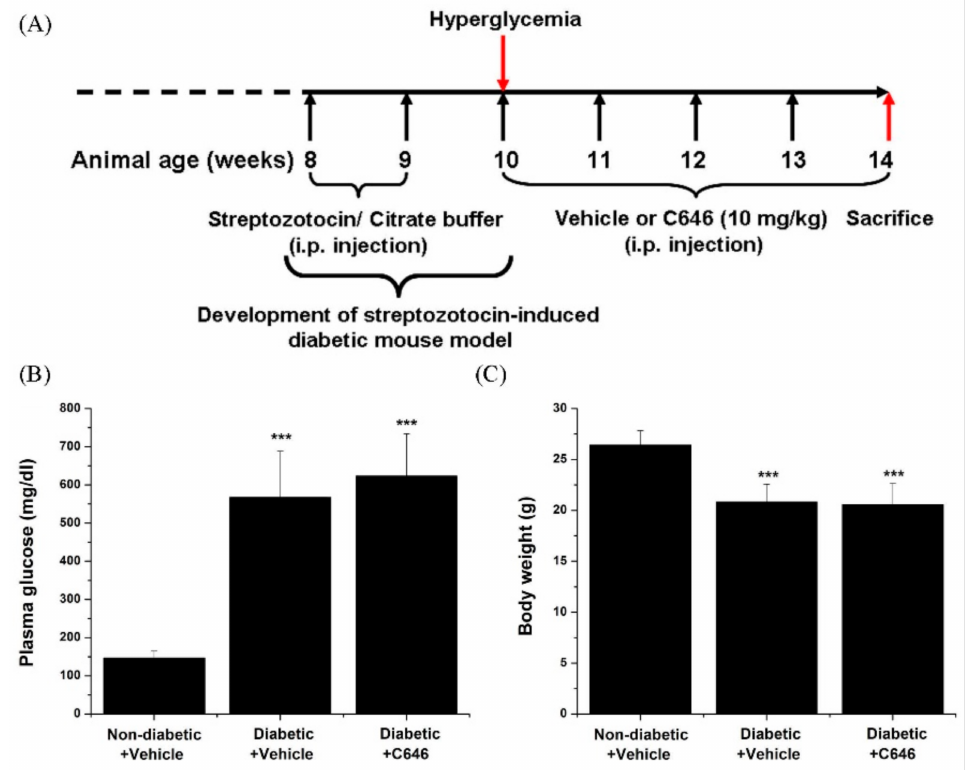
Figure 1. ( A ) Schematic depiction of the experimental set-up to induce diabetes in C57BL/6J mice and the duration of C646/vehicle administration to mice. ( B , C ) Plasma glucose levels and body weights were assessed for each animal group at the end of the treatment procedure. n = 5–7, *** p < 0.001. p -values were taken in relation to non-diabetic + vehicle